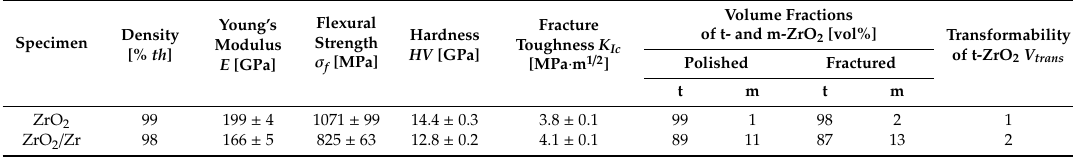
Table 1. Densities and mechanical properties of all studied specimens, as well as volume fractions of tetragonal “t” and monoclinic “m” zirconia in polished and fractured surfaces and the resulting transformability of tetragonal